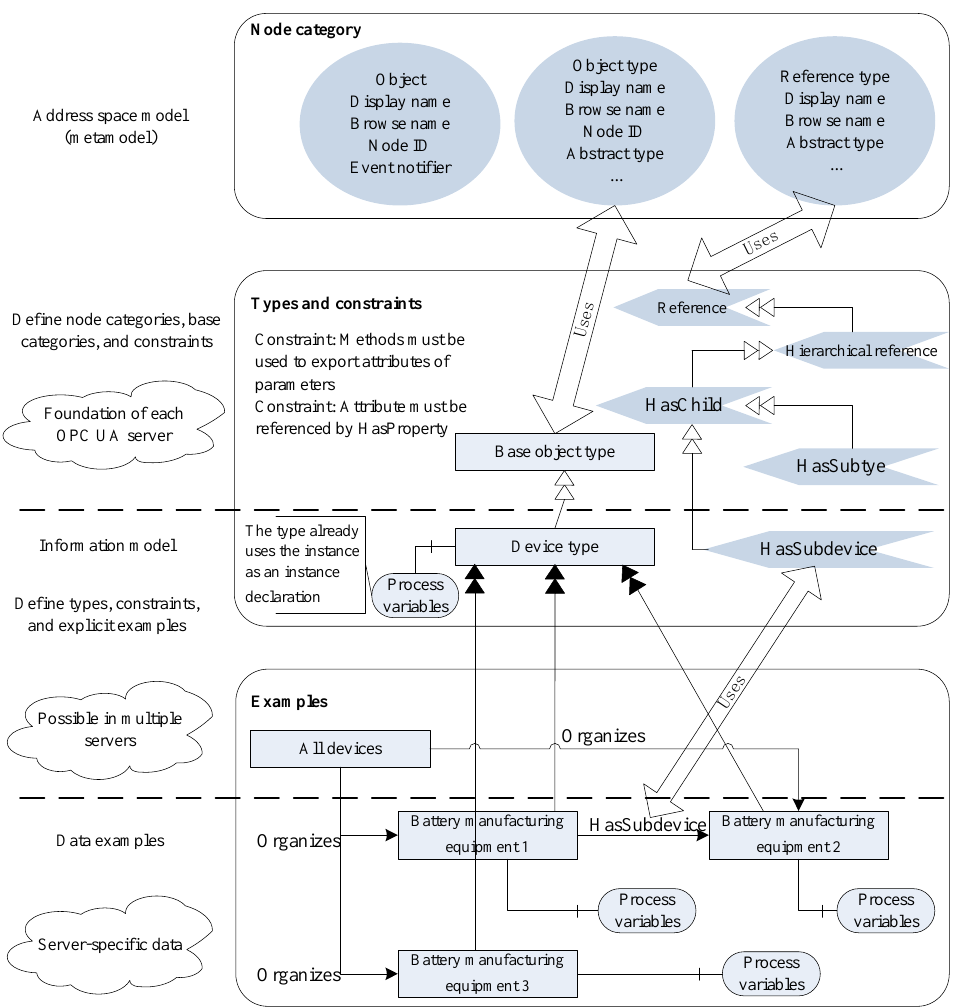
Figure 7. OPC UA address space model, information model, and data example.